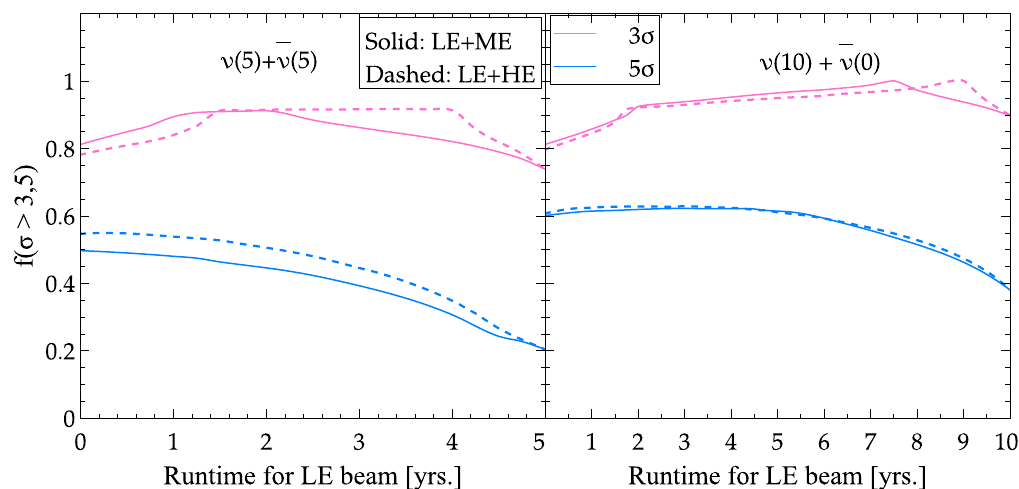
Figure 22.4: The fraction of the values of δ for which SI and NSI scenarios can be distinguished above 3 σ (magenta) and 5 σ (blue) using different combinations of beam tunes (LE + ME or LE + HE). The plot is taken from [ 377 ] . sensitivities. The estimate of the fraction of δ values thus depends on the points of intersection of the sensitivity curve with the 3 σ (or 5 σ ) horizontal lines in Fig.